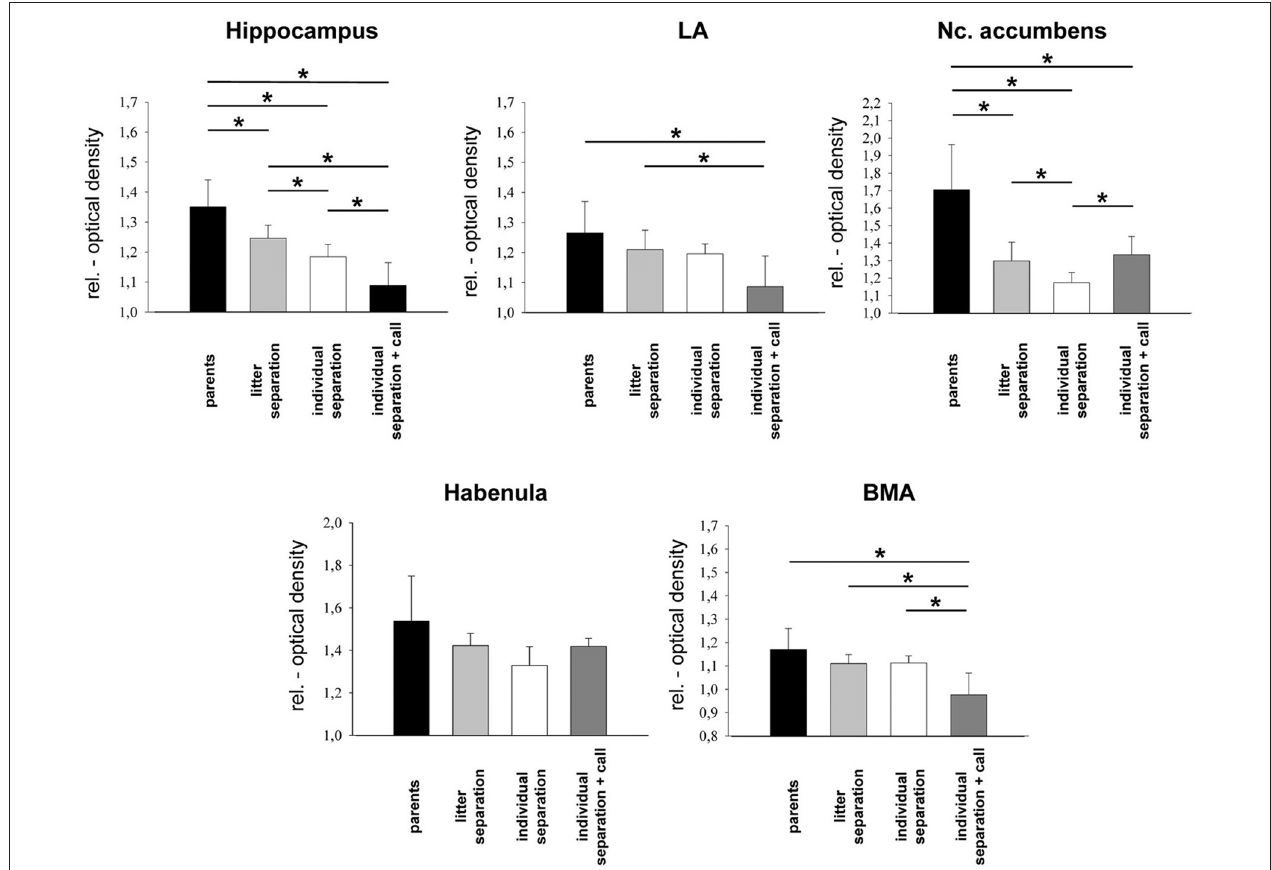
FIGURE 2 | Relative optical density of limbic brain areas in the four experimental groups. ∗ p ≤ 0.05, Mann–Whitney U -test. BMA, basomedial amygdala; LA, lateral